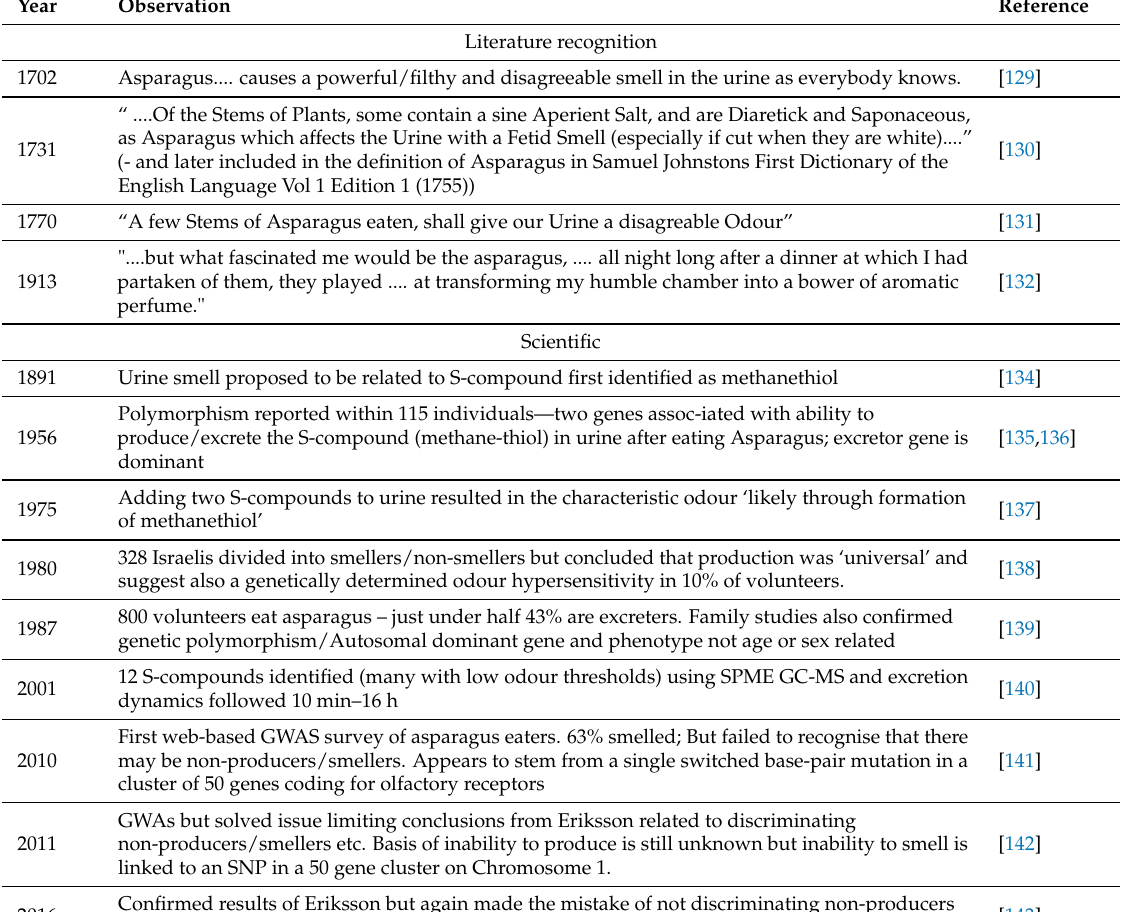
Table 3. Seminal moments in the history of smelly asparagus